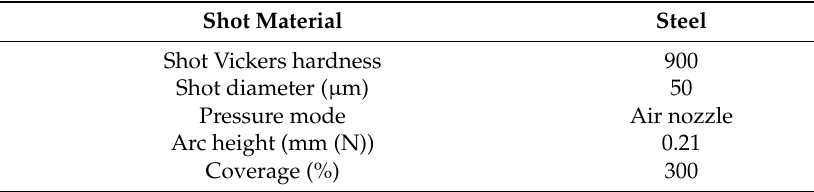
Table 2. Fine-particle peening conditions. Table 2. Fine ‐ particle peening conditions.